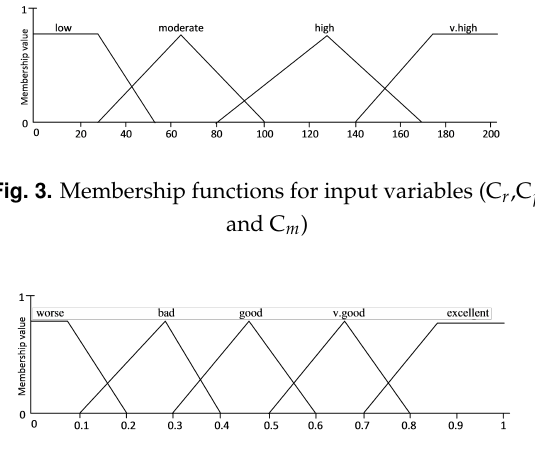
Fig. 4. Membership function for output variable